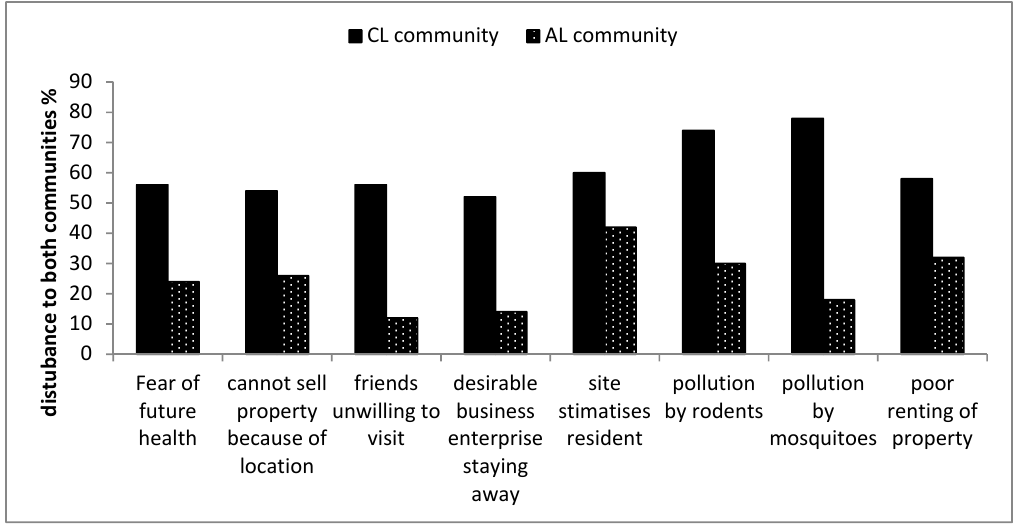
Figure 11. Comparison between both communities showing how disturbing these external factors were to them.